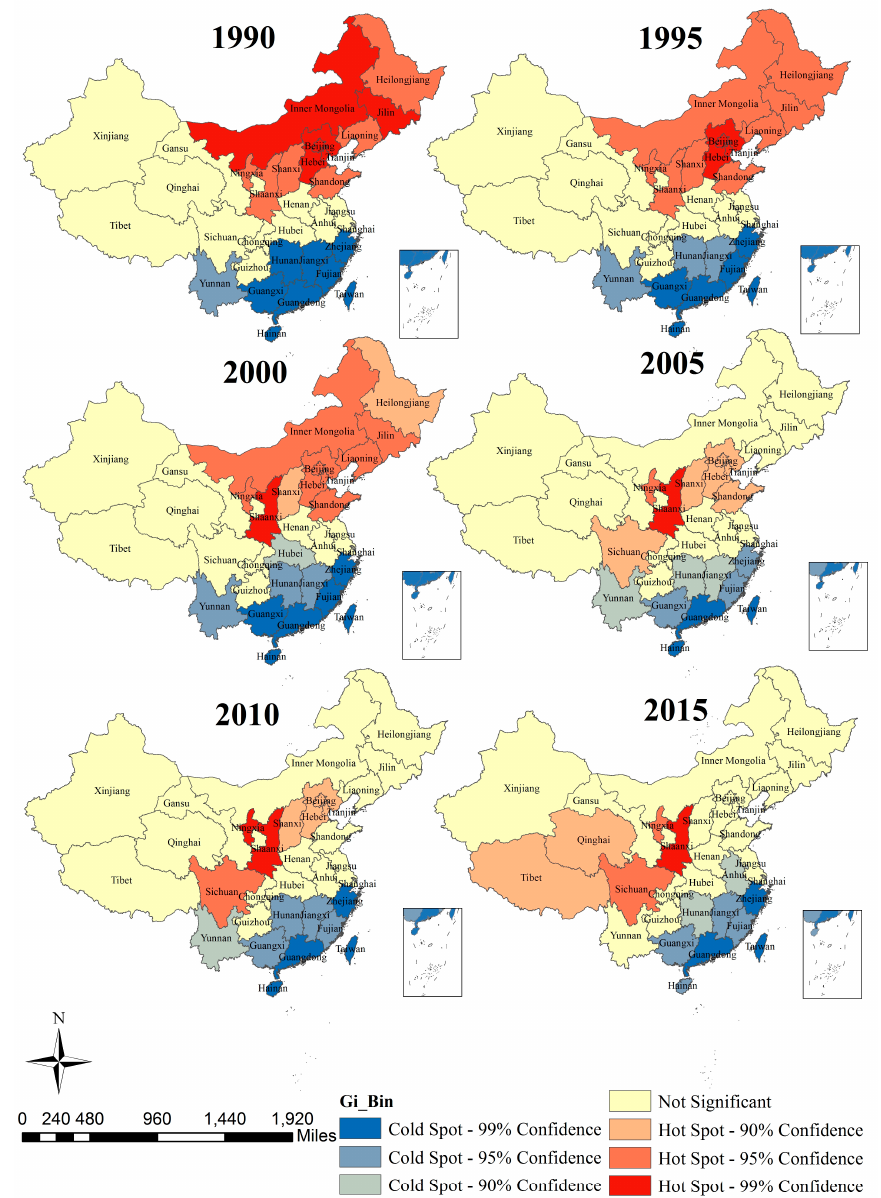
Figure 10. Local spatial autocorrelation of stroke mortality PM-2.5 in 1990–2015, China.